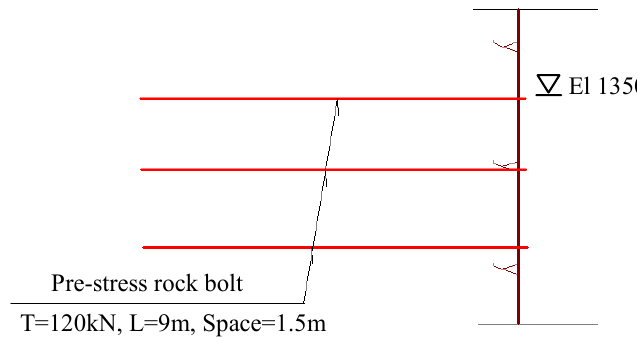
Figure 14. Anchor reinforcement design of the upstream side wall at the R 0+263 region.